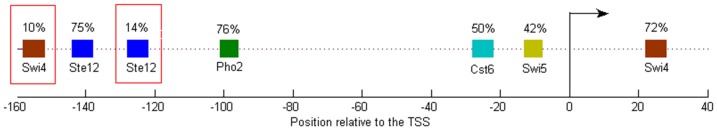
Seven putative TFBSs were predicted in the promoter of FZF1.In the promoter of FZF1, there are 7 computationally predicted TFBSs belonging to 5 different TFs (Swi4, Ste12, Pho2, Cst6, and Swi6) according to MacIsaac et al.'s TFBS datasets. Among these 7 putative TFBSs, our post-processor identified two TFBSs with high functional propensities to be worthy of further study. One is Swi4's TFBS, located from −158 bp to −152 bp relative to the TSS, whose functional propensity is within the largest 10% of the functional propensities of all computationally predicted Swi4's TFBSs, and the other one is Ste12's TFBS, located from −128 bp to −122 bp relative to the TSS, whose functional propensity is within the largest 14% of the functional propensities of all computationally predicted Ste12's TFBSs.